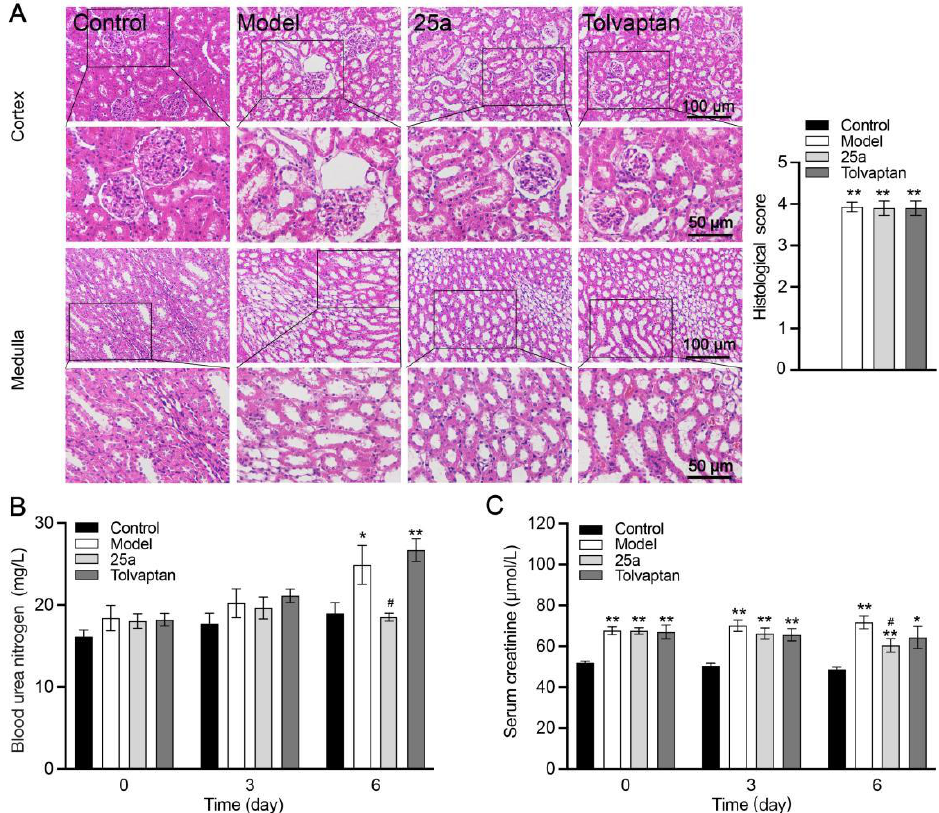
Figure 4. Kidney tissue morphology and function in rats. ( A ) H&E-stained kidney tissue sections and histological scores. ( B ) Blood urea nitrogen (BUN). ( C ) Serum creatinine. Data are presented as means ± SEM, n = 7. * p < 0.05 and ** p < 0.01 vs. control group; # p < 0.05 vs. model group. The data were analyzed by one- way ANOVA with Tukey’s HSD post hoc test.